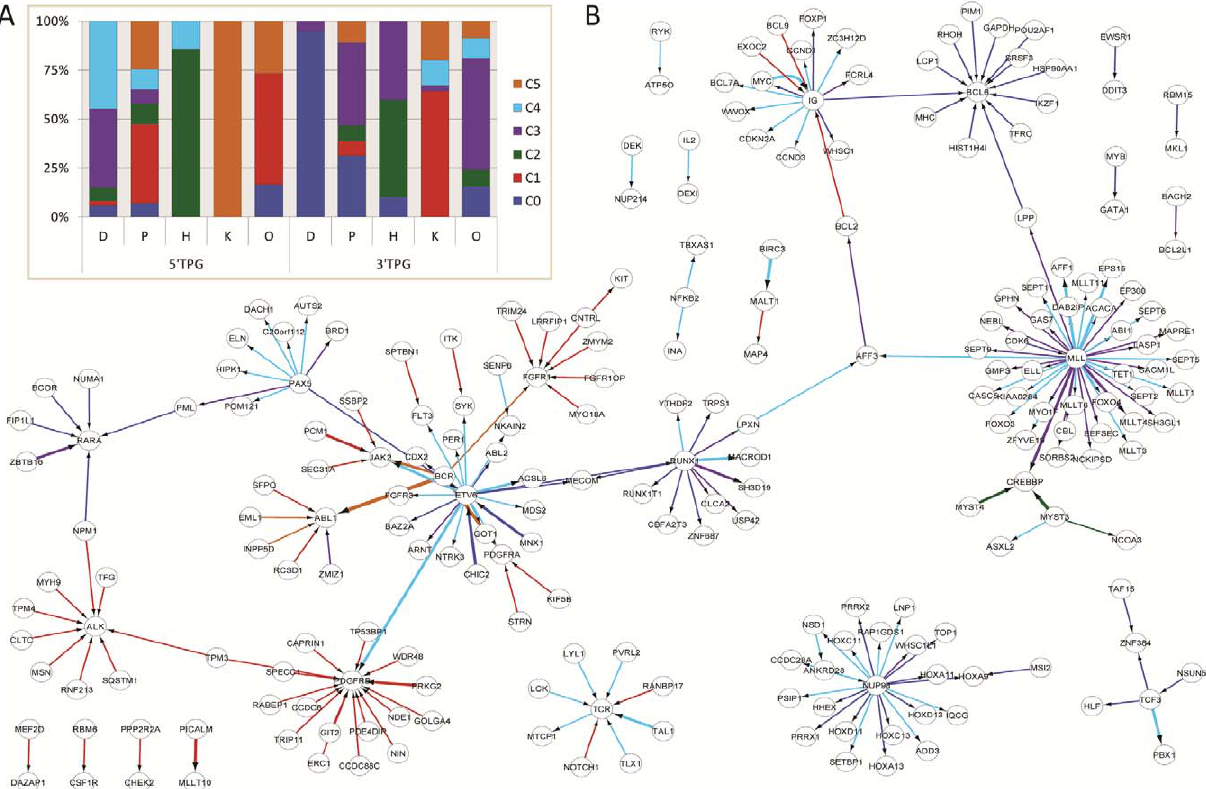
Figure 6. Unsupervised clustering of translocation fusion proteins based on their domain profiles yields 6 translocation classes (C0 to C5). A : Relative probabilities of proteins encoded by 5 9 or 3 9 TPGs to have at least one domain of D/P/H/K/O functional class for each of the six translocation classes. B . Network of TPGs (arrows point from 5 9 to 3 9 TPG) showing how translocation classes are consistent with specific combinations of TPGs (MLL translocations include classes C3 and C4, ALK and PDGFRB translocations are almost exclusively class C1, etc). Edge thickness indicates number of different TPG variants comprising a given translocation.